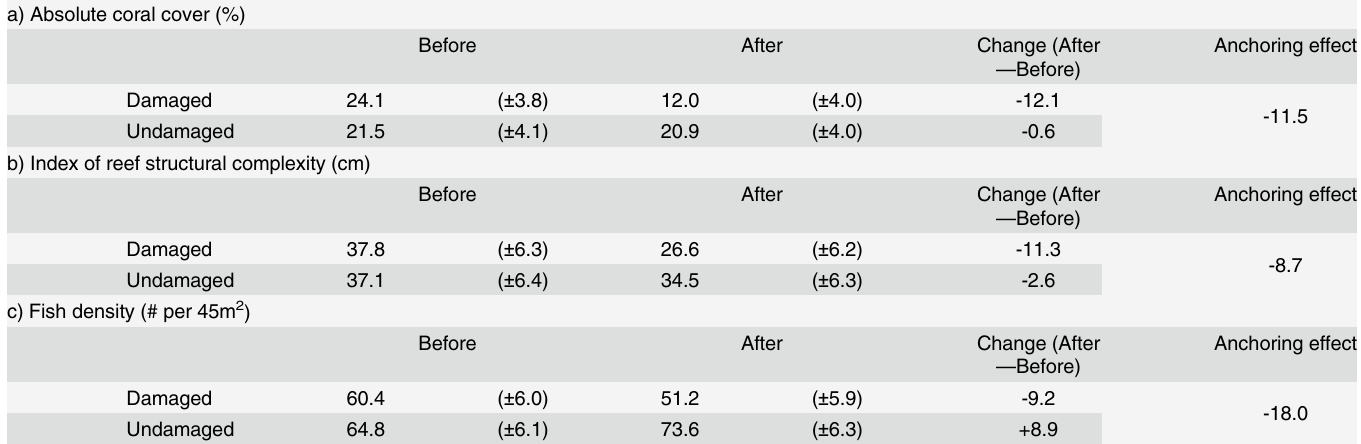
Table 1. Three measures of community state (coral cover, reef structural complexity, and fish density) before and after the 2004 anchoring event, in the damaged and undamaged part of the site. Shown are marginal means ( ± SE) from the linear mixed model, which are adjusted for other variables in the model. Calculation of the anchoring effect is explained in the text.